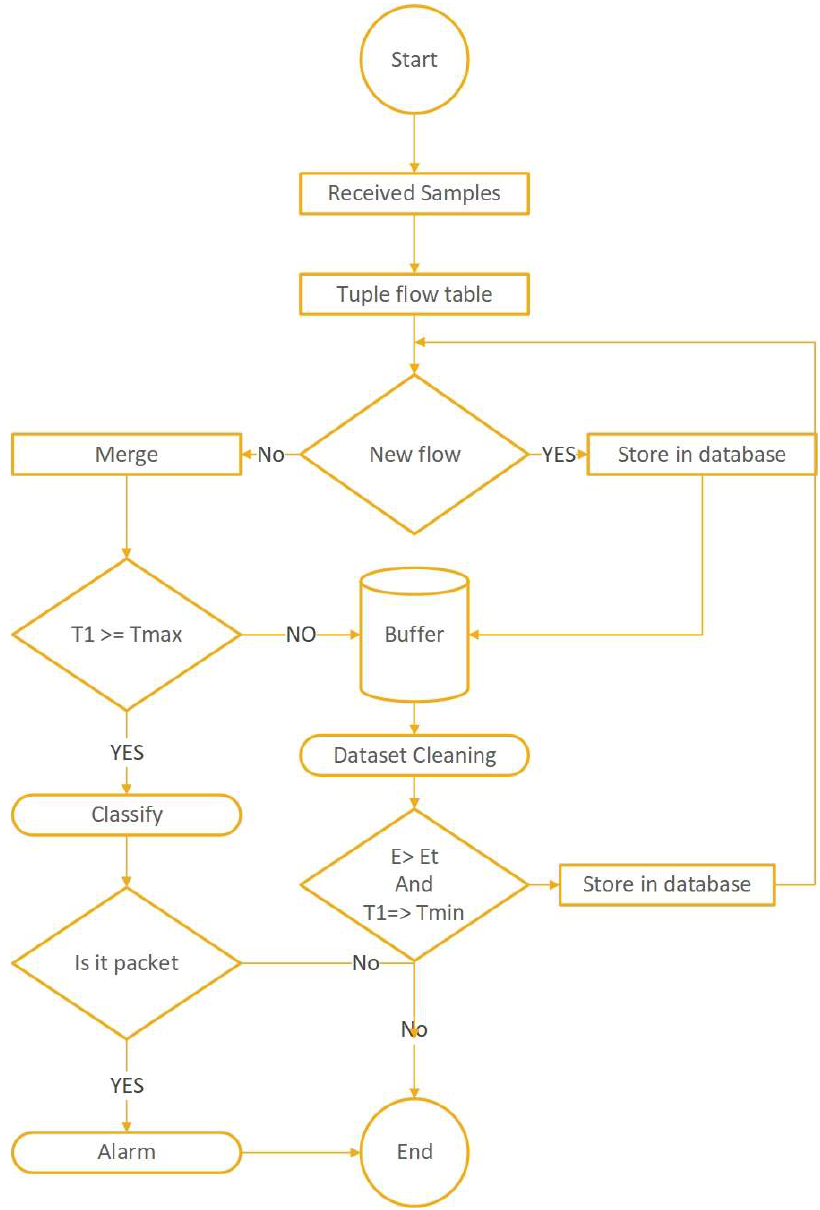
Figure 3. Proposed detection system flowchart.